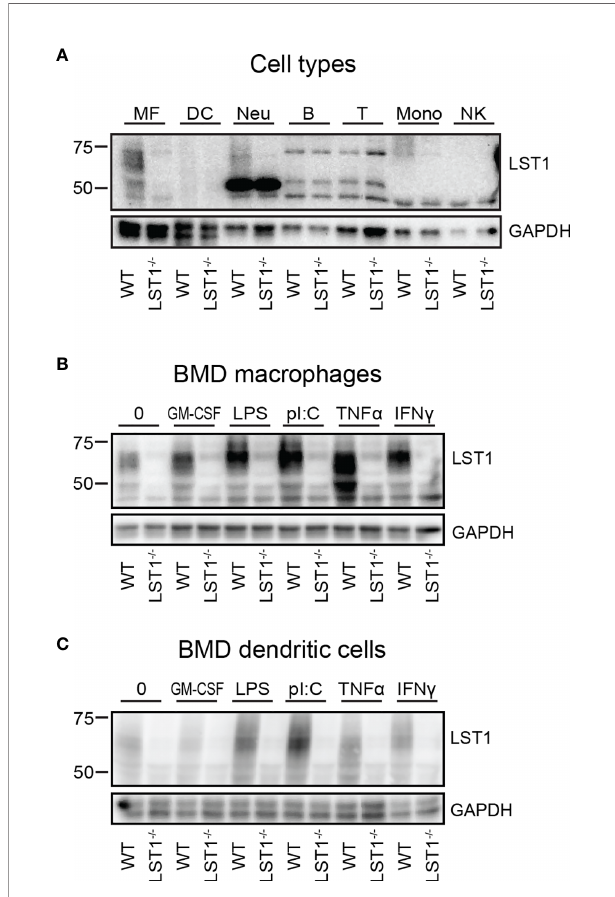
FIGURE 2 | Murine LST1 is expressed in the cells of myeloid lineage and its expression increases after pro-in fl ammatory stimuli. (A) Murine LST1 was detected in total cell lysates by immunoblotting (n=3). MF – bone marrow derived macrophages, DC – bone marrow derived dendritic cells, Neu – Neutrophils, B – B cells, T – T cells, Mono – monocytes, NK – NK cells. Its molecular weight varies between 42 to 71 kDa, likely due to the glycosylation. (B, C) Expression of LST1 in bone marrow derived macrophages (B) and dendritic cells (C) after treatment with various pro-in fl ammatory stimuli (n=3, see Materials and Methods for concentrations).